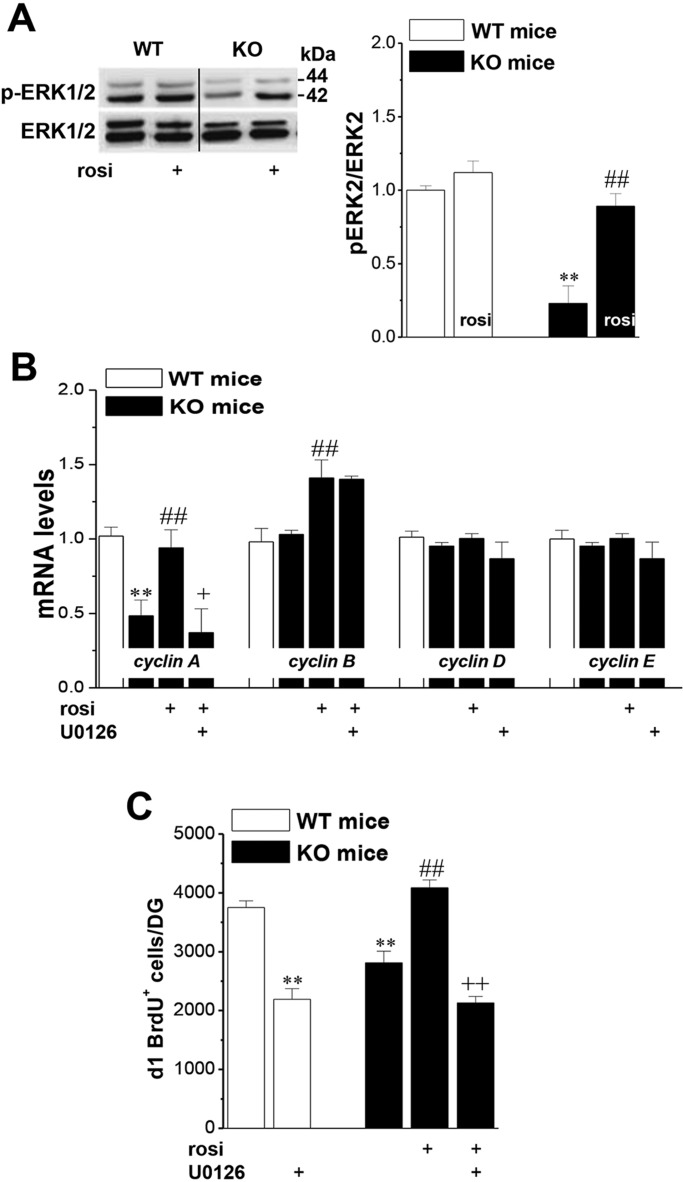
Seipin deficiency suppresses phospho-ERK2 and cyclin A expression. (A) Densitometric values of phospho-ERK2. **P<0.01 vs WT mice; ##P<0.01 vs seipin-nKO mice. (B) Levels of cyclin A, cyclin B, cyclin D and cyclin E mRNA normalized by control values. **P<0.01 vs WT mice; ##P<0.01 vs seipin-nKO mice; +P<0.05 vs rosi-treated seipin-nKO mice. (C) Effect of the MEK inhibitor U0126 on rosi-protected neurogenesis. Bar graph shows mean number of d1 (1 day after last BrdU injection) BrdU+ cells in seipin-nKO mice and WT mice treated with U0126, rosi or rosi+U0126. **P<0.01 vs WT mice; ##P<0.01 vs seipin-nKO mice; ++P<0.01 vs rosi-treated seipin-nKO mice.